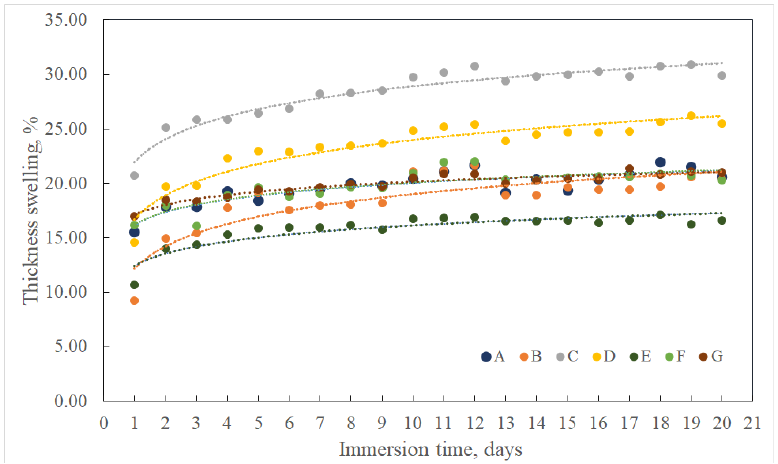
Figure 1. Relationship between immersion time and thickness swelling of particleboard samples with dimensions 2.5 × 2.5 cm for all categories (A–G).